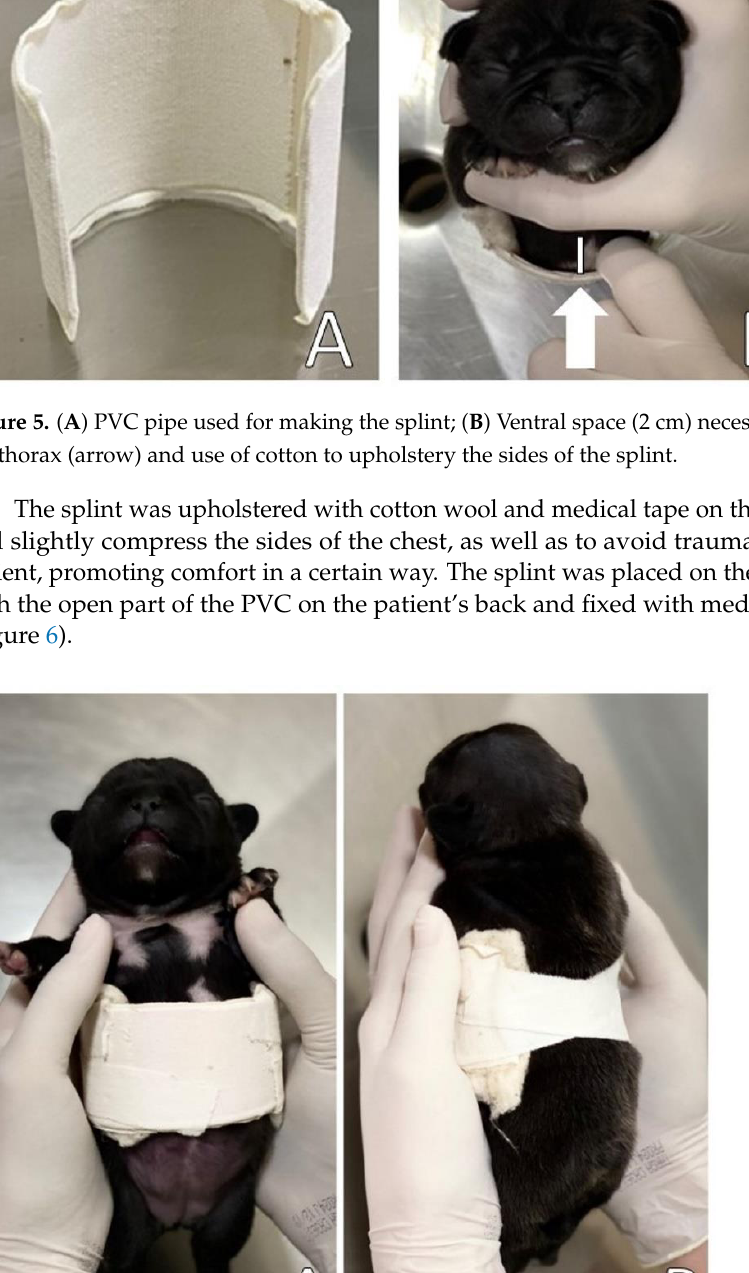
Figure 7. Patient nursing during splint use. On the return, eight days after the beginning of management, chest remodeling was observed, with the thorax correctly aligned, with absence of depression in the sternum